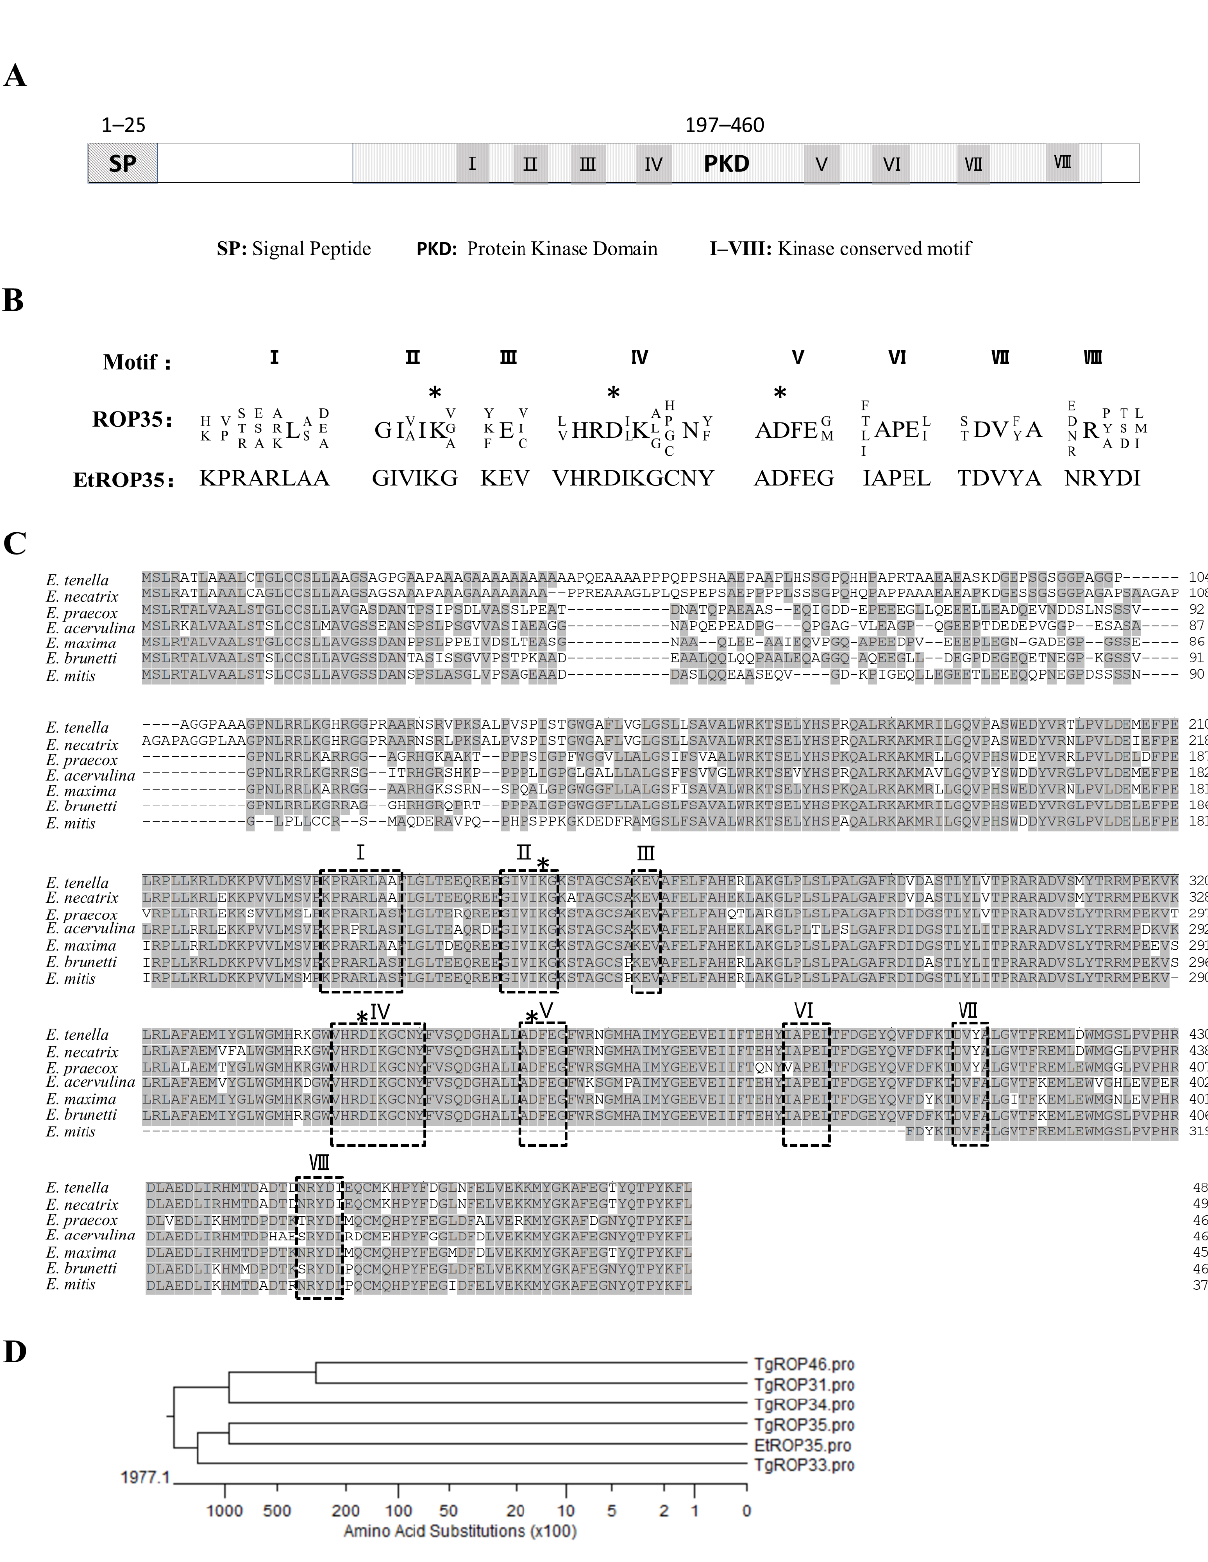
Figure 1. Identification and characterization of EtROP35. ( A ) Primary structure of EtROP35. ( B ) Eight conserved ROP35-subfamily motifs. ( C ) Alignment analysis of the EtROP35 homologous protein sequences in Eimeria. Conserved motifs of protein kinase (I–VIII) are framed out with dotted lines. Asterisks (*) indicate the active sites. ( D ) Evolutionary relationship analysis of EtROP35 with the homologous proteins of T. gondii by the MegAlign software v7.1.0 (DNASTAR Inc., Madison, WI, USA).